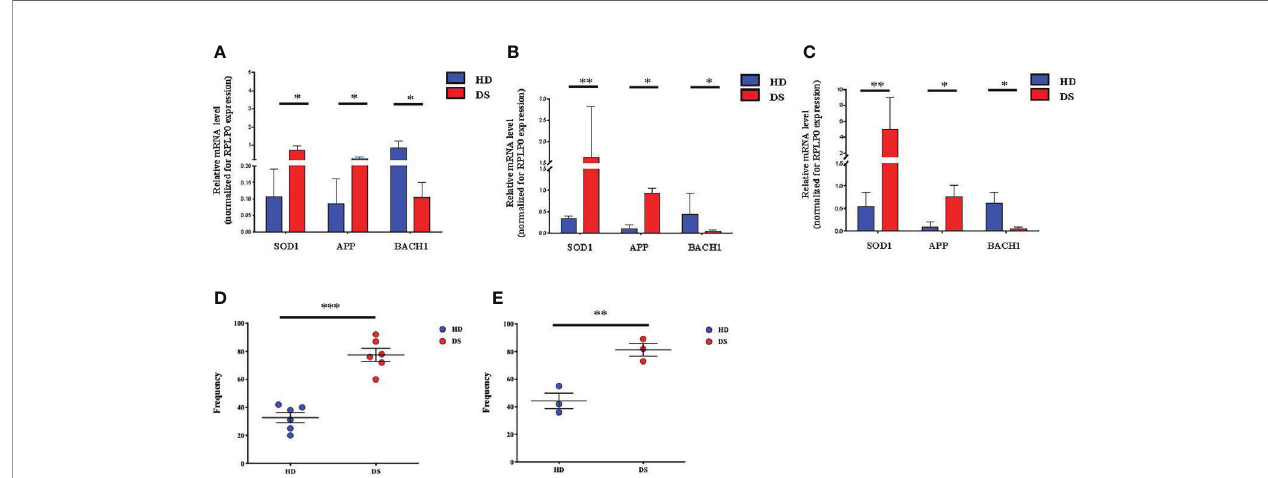
FIGURE 5 | Oxidative stress detection in TEC, thymocytes and PBMCs. (A – C) Comparison of mRNA expression of oxidative stress-associated genes (SOD1, APP, BACH1), in TEC (A) , thymocytes (B) and PBMCs (C) isolated from DS patients and age-matched HDs, normalized for the expression of the housekeeping gene RPLP0 (TEC and thymocytes: HD, n = 12, sample 13 in Supplemental Table 2 was excluded from the analyses; DS, n = 9, from sample 1 to sample 9 in Supplemental Table 3 . PBMCs: HD, n = 12, sample 13 in Supplemental Table 2 was excluded from the analyses; DS, n = 9, from sample 1 to sample 9 in Supplemental Table 3 ). (D) Frequency of mitochondria function and number in PBMCs evaluated on the gate of total CD45 + CD3 + T lymphocytes isolated from DS patients and age-matched HDs (HD, n = 6, samples 2, 7, 9, 10, 11,12 in Supplemental Table 2 ; DS, n = 6, samples 1, 6, 9, 10, 11, 12 in Supplemental Table 3 ). (E) Analysis of mitochondrial membrane potential, expressed as frequency and calculated on the gate of total CD45 + CD3 + T lymphocytes isolated from DS patients and age-matched HDs (HD, n = 3, samples 2, 7, 11 in Supplemental Table 2 ; DS, n = 3, samples 10, 11, 12 in Supplemental Table 3 ). Mean ± SEM are represented (Mann-Whitney test; * p -value < 0.05; ** p -value < 0.002; *** p -value <